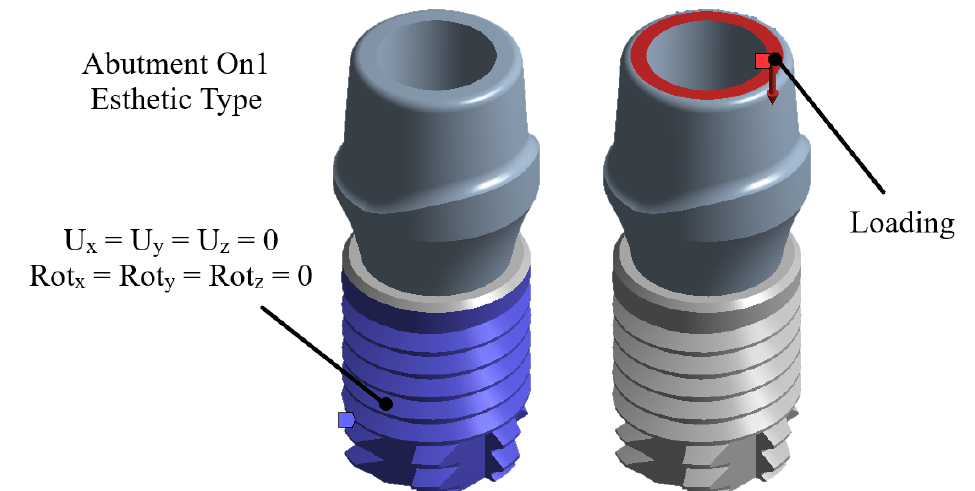
Figure 8. Boundary conditions and external loads on the